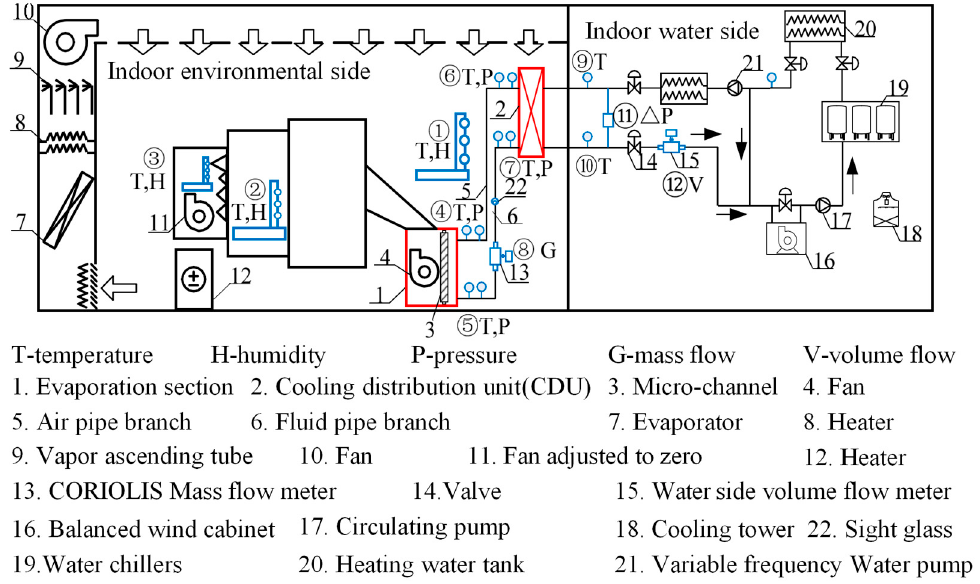
Figure 2. Schematic diagram of backplane heat pipe test platform of enthalpy difference laboratory.